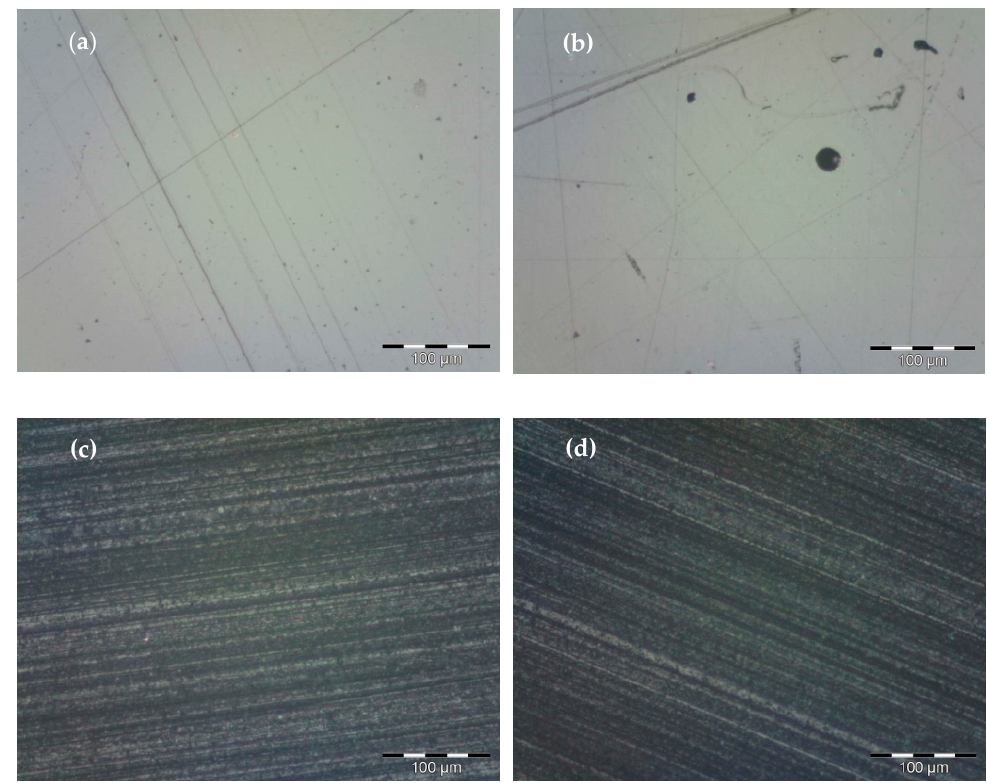
Figure 3. Photos from an optical microscope at 100 times magnification: ( a ) FU after binding under Mylar strip; ( b ) FZ after binding under Mylar strip; ( c ) FU after grinding with 600 grit sandpaper; ( d ) FZ after grinding with 600 grit sandpaper.